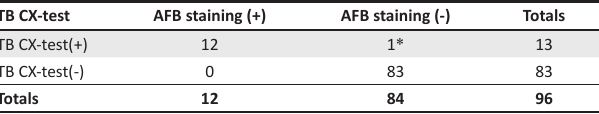
TABLE 1: Participant demographics and clinical characteristics. Demographic